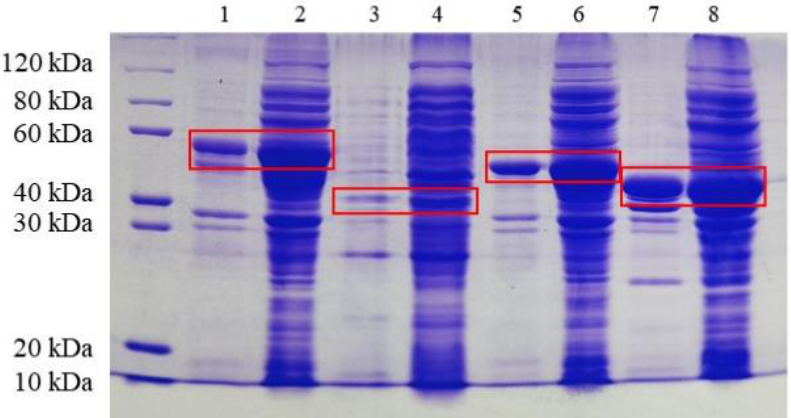
Figure 6. SDS-PAGE analysis of the expression of four recombinant fusion enzymes in E. coli . Lane 1 and 2: SpyCatcher-CpCR cell fragmentation pellet and supernatant; Lane 3 and 4: SpyTag-GDH cell fragmentation pellet and supernatant; Lane 5 and 6: SpyTag-CpCR cell fragmentation pellet and supernatant; Lane 7 and 8: SpyCatcher-GDH cell fragmentation pellet and supernatant.